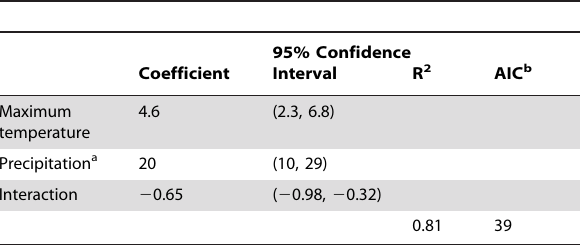
Table 2. Determinants of logit-transformed R 2 between GDT and reported dengue cases: Multiple covariate